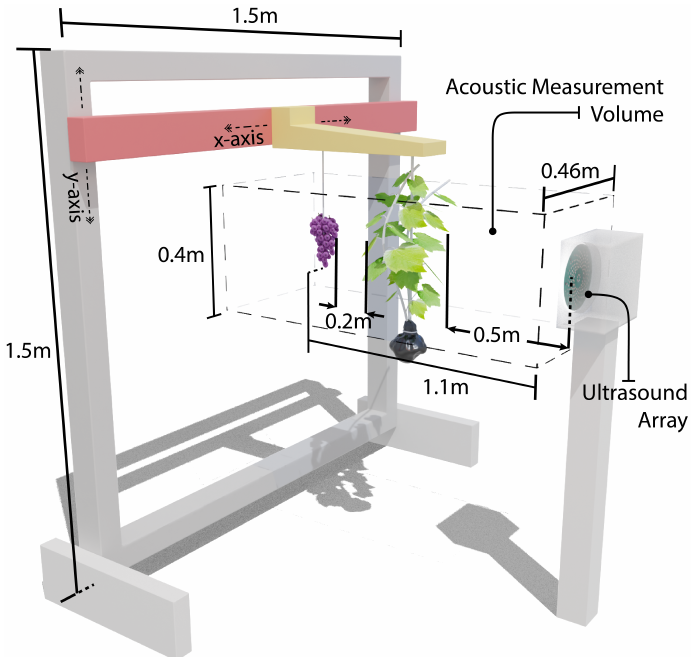
Figure 7. Diagram of the experimental setup showing the grapevine and grape bunch suspended from the CNC machine in front of the ultrasonic array and volume of area where ultrasonic measurements were